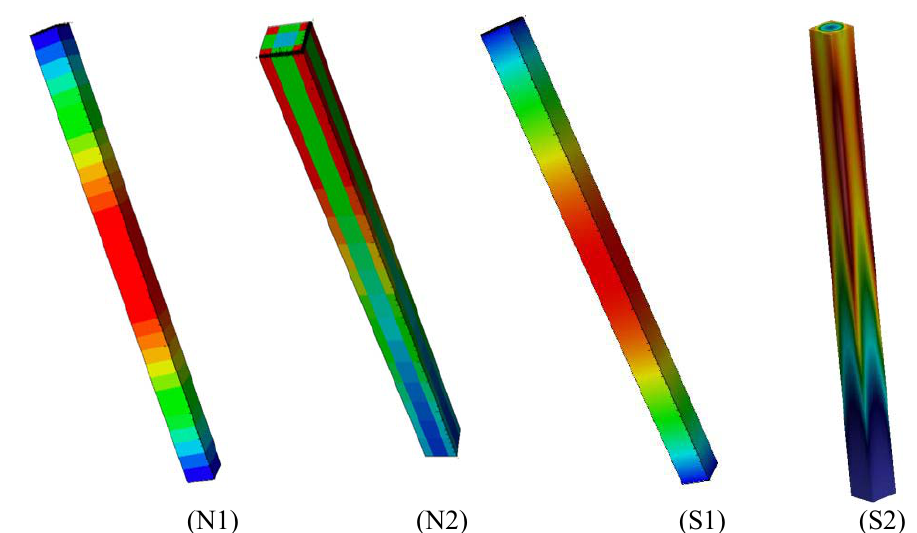
Figure 3. Precursor distributions corresponding to cases N1, N2, S1, and S2 from Table